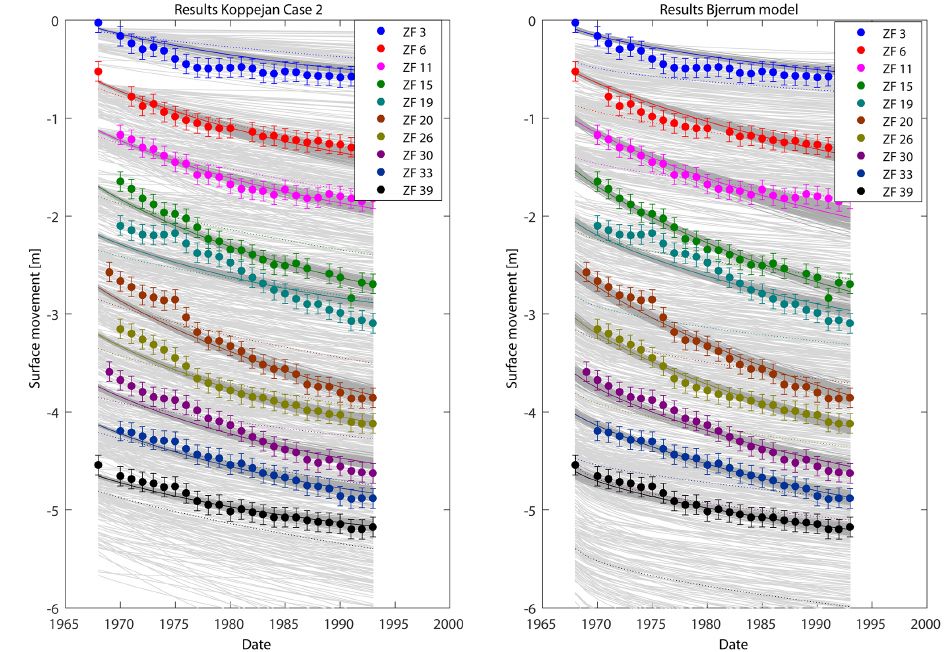
Figure 3. Surface movement data and predictions before and after data assimilation. Subsequent series are shifted downward by 0.5m. Colored circles: data; colored dashed lines: average prior estimate; colored solid lines: average assimilated estimate. Light grey lines: prior ensemble predictions. Dark grey lines: posterior ensemble predictions. Case 2, with less constrained prior gives larger prior spread and better estimates than Case